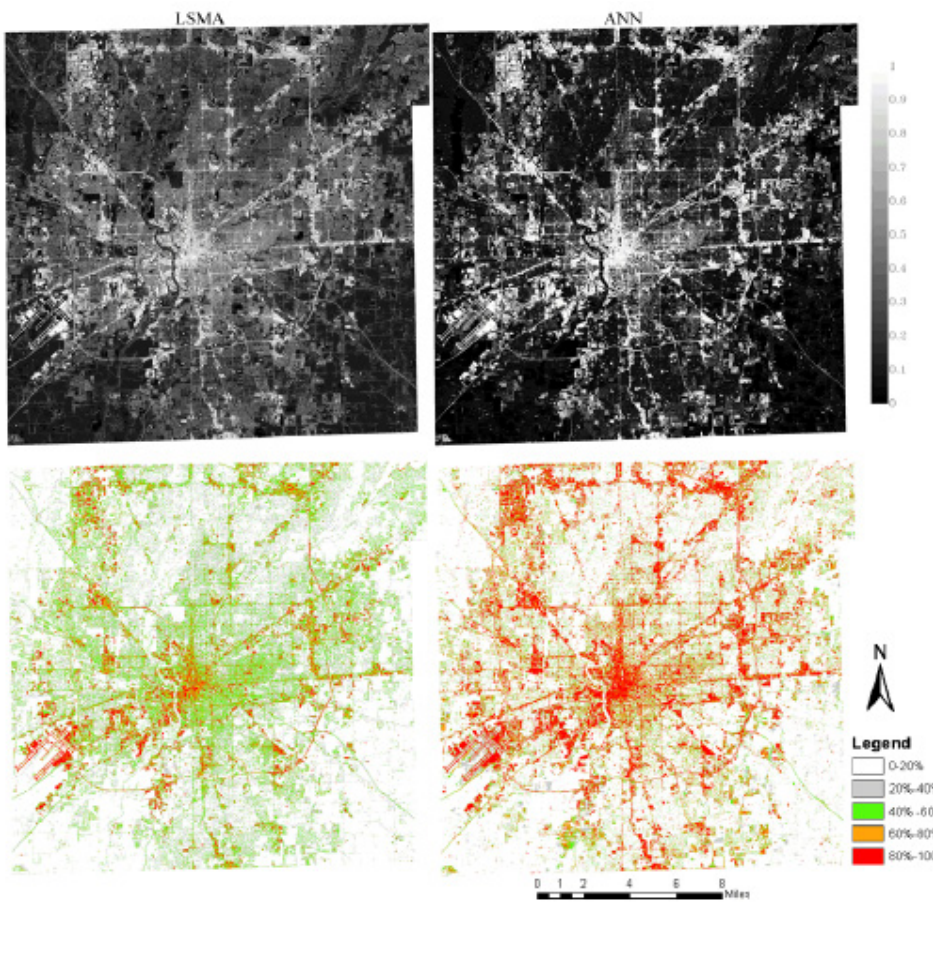
Figure 2. Impervious surface images of Indianapolis derived from a Terra’s ASTER image of June 16,